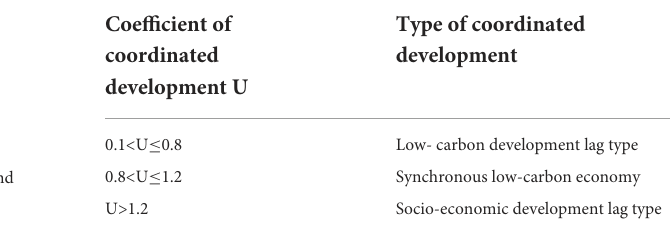
TABLE 4 Criteria for evaluating the coefficient of coordinated development between low-carbon and socio-economic development.